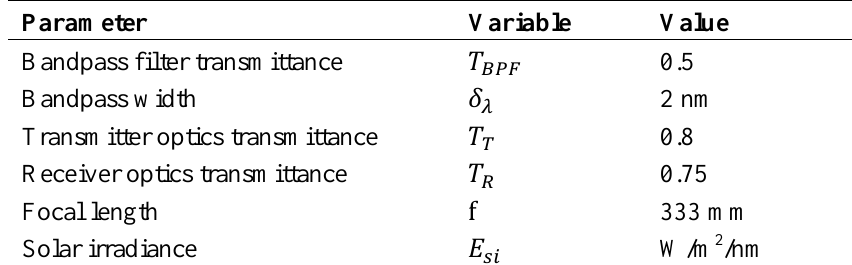
Table 5. Parameters of the optics (related to Equations (1), (15) and